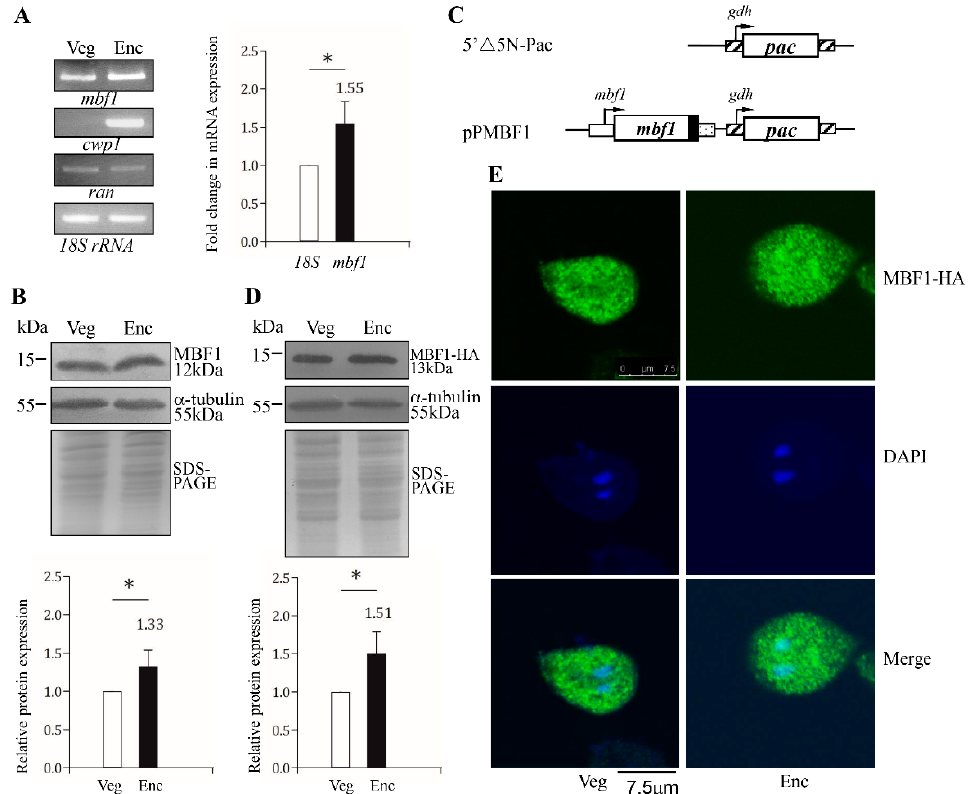
Figure 2. MBF1 protein and mRNA expression. ( A ) RT-PCR and quantitative real-time PCR analysis. RNA was extracted from G. lamblia wild type non-transfected WB cells cultured in growth medium (Veg, vegetative growth) or encystation medium for 24 h (Enc, encystation). RT-PCR was performed using primers for genes indicated in the figure (left panel). The mRNA levels of the cwp1 and ran genes significantly increased and decreased during encystation, respectively. Real-time PCR was performed using primers for genes indicated in the figure (right panel). The mRNA levels were normalized to the 18S ribosomal RNA level. The ratio of mRNA levels in Enc sample to levels in Veg sample is shown and expressed as the means ± 95% confidence intervals of at least three separate experiments. *, p < 0.05. ( B ) MBF1 protein level increased during encystation. The wild type non-transfected WB cells were incubated in growth medium (Veg, vegetative growth) or encystation medium for 24 h (Enc, encystation) and then subjected to Western blot analysis using anti-MBF1 and anti- α -tubulin antibodies, respectively. SDS-PAGE and Coomassie Blue staining is included as a control for equal protein loading. The level of α -tubulin protein is slightly decreased in encystation sample. The band intensity from triplicate Western blots was quantified using Image J. The MBF1 protein levels were normalized to the loading control (Coomassie Blue-stained proteins). The ratio of MBF1 protein levels in Enc sample to levels in Veg sample is shown and expressed as mean ± 95% confidence intervals. *, p < 0.05. ( C ) Schematic presentation of the 5 (cid:48) ∆ 5N-Pac and pPMBF1